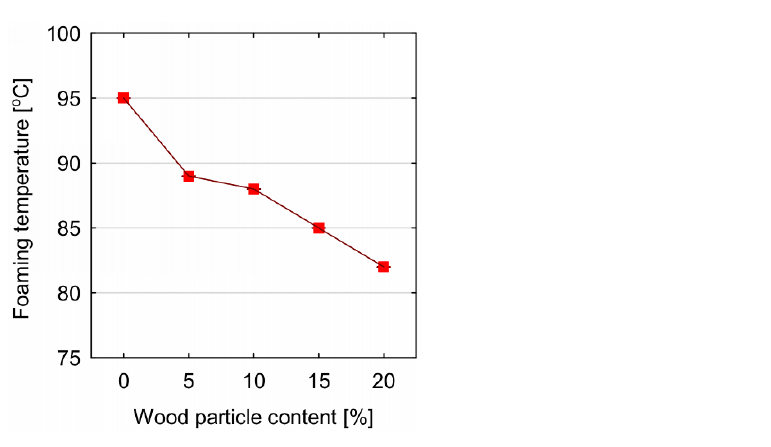
Figure 4. Times characterizing the foaming process of PUR-WP composition depending on wood particle content. Different letters indicate homogeneous groups of mean values determined by one-factor ANOVA with Tukey’s test.